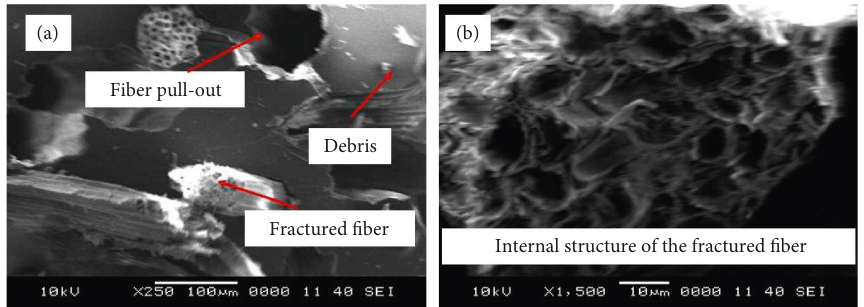
Figure 4: SEM images after tensile test. (a) SiO